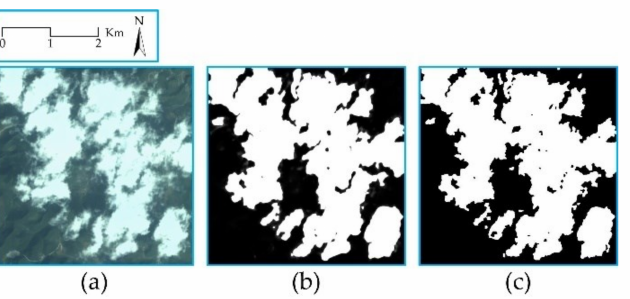
Figure 6. Folding–unfolding and max-pooling results. ( a ) The original RGB image; ( b ) the max- pooling result; ( c ) the folding–unfolding result. The coordinates of ( a ) are 107.2E and